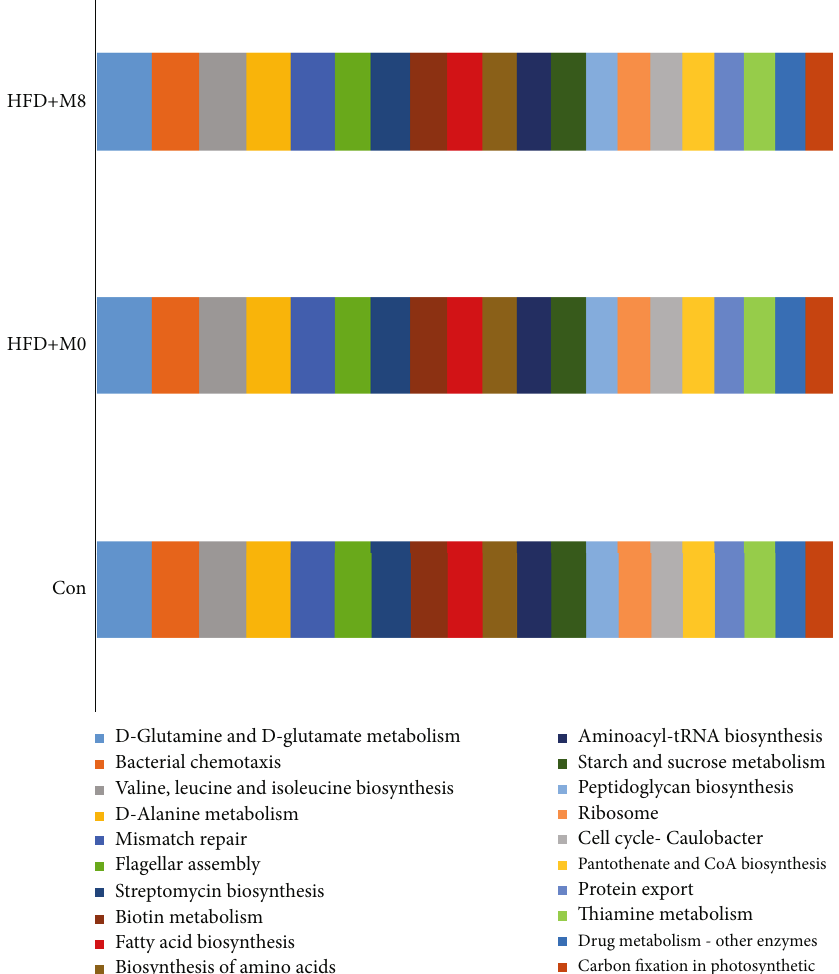
Figure 6: E ff ects of high-fat diet-supplemented methionine on gut bacterial COG function classi fi cation ( n = 3